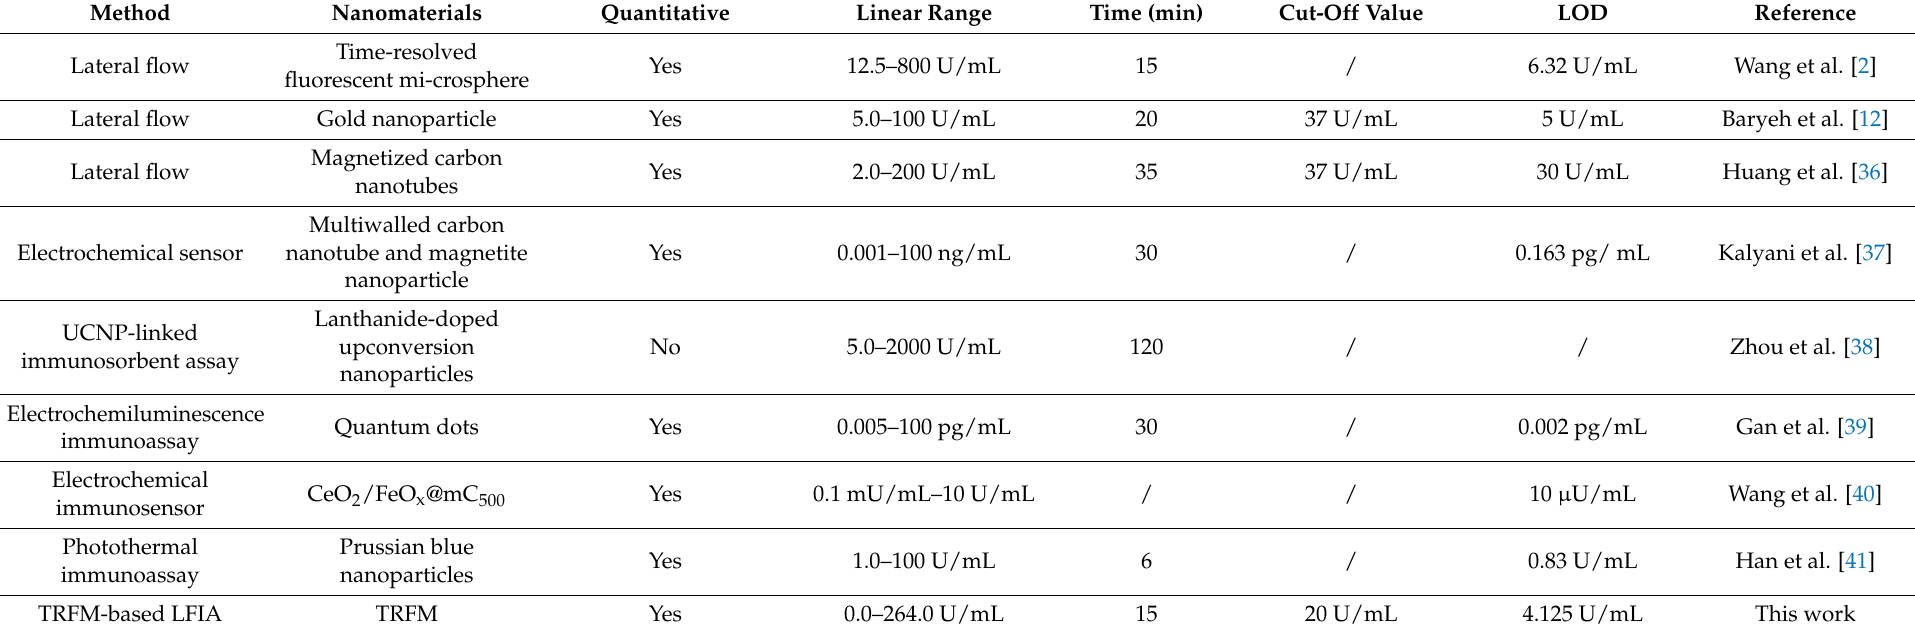
Table 2. A summary of immunoassays for detection of